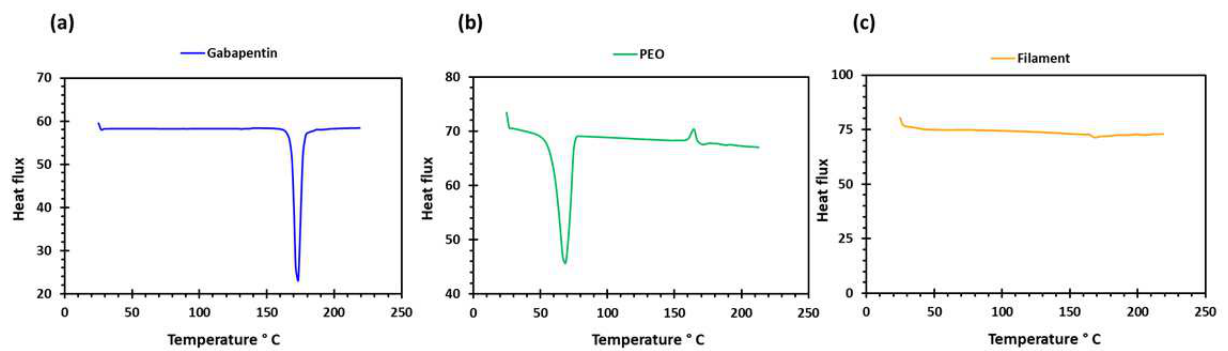
Figure 2. DSC profiles of ( a ) gabapentin; ( b ) polyethylene oxide (PEO); and ( c ) GBP/PEO filament.